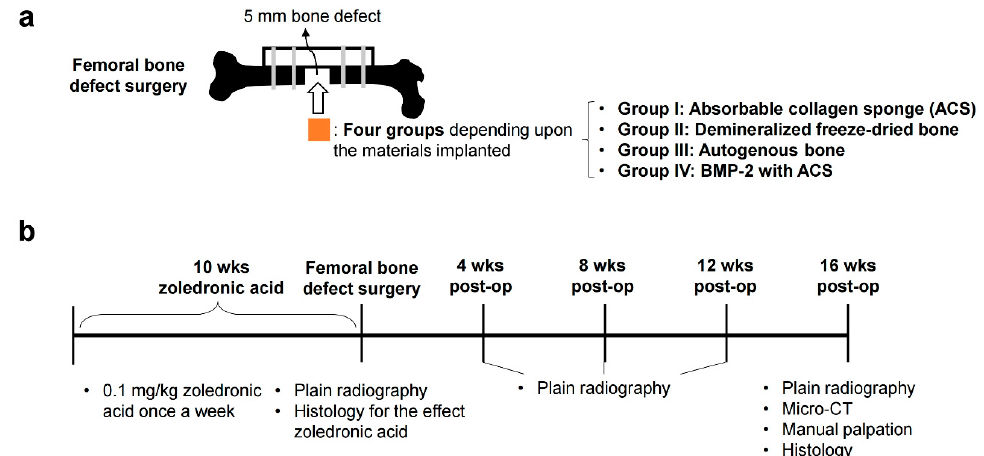
Figure 1. A schematic diagram of study design. ( a ) The schematic figure of femoral bone defect surgery. Each animal was performed with a 5 mm femoral bone defect, stabilized by a polyethylene plate with K-wire. The defects were implanted with an absorbable collagen sponge (group I), with demineralized freeze-dried bone (group II), with autogenous bone (group III), or with BMP-2 with an absorbable collagen sponge (group IV). ( b ) The study’s timeline indicates the time points for injection of zoledronic acid, femoral bone defect surgery, radiology, histology, micro-CT, and manual